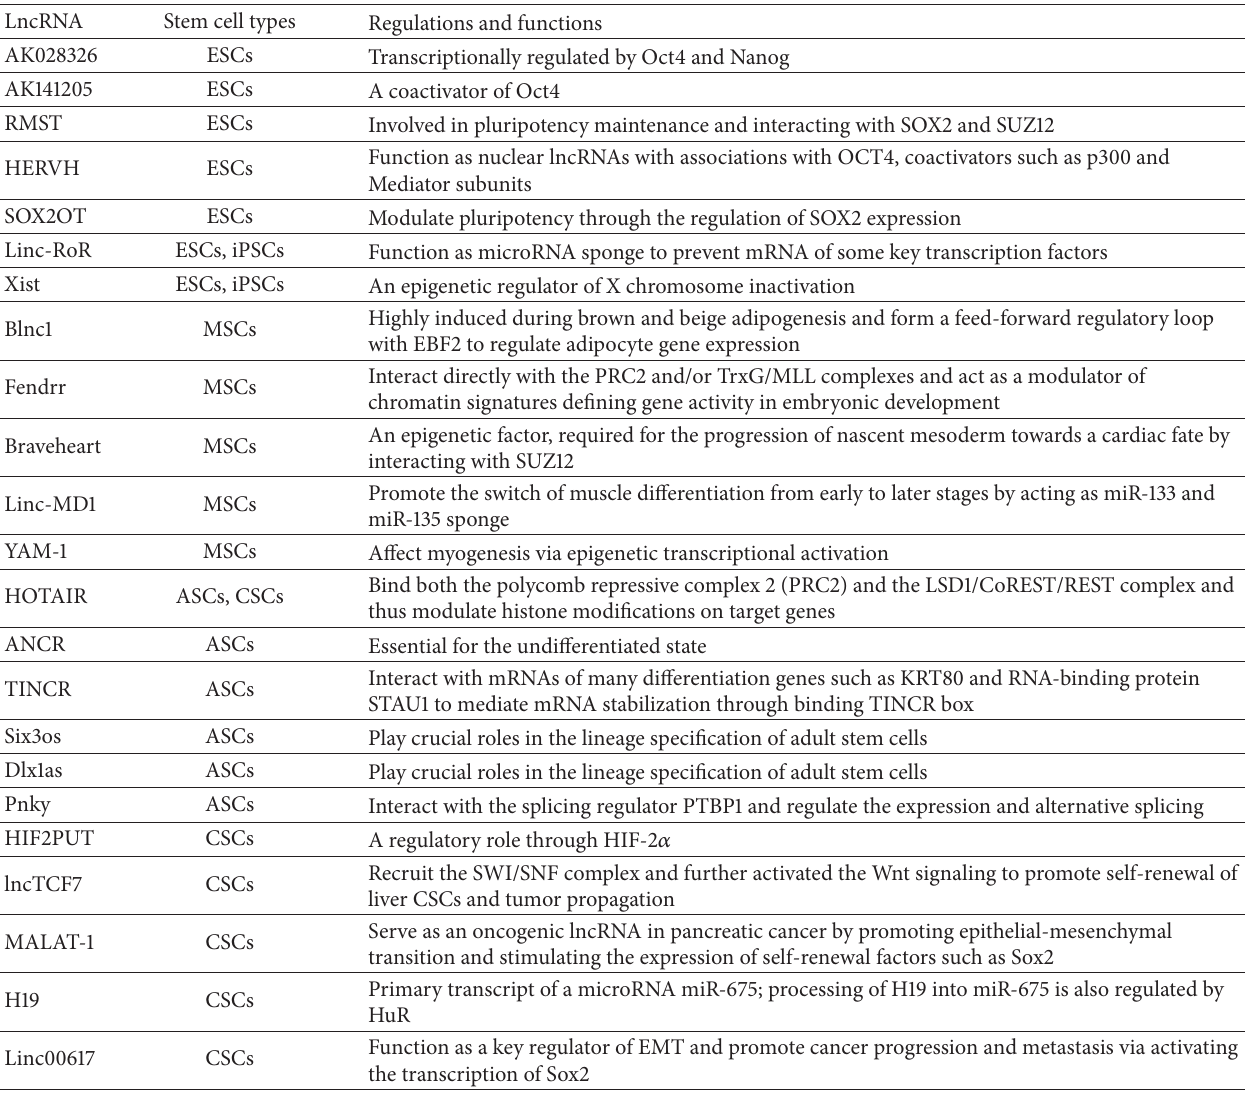
Table 2: Regulatory roles of lncRNAs in different stem